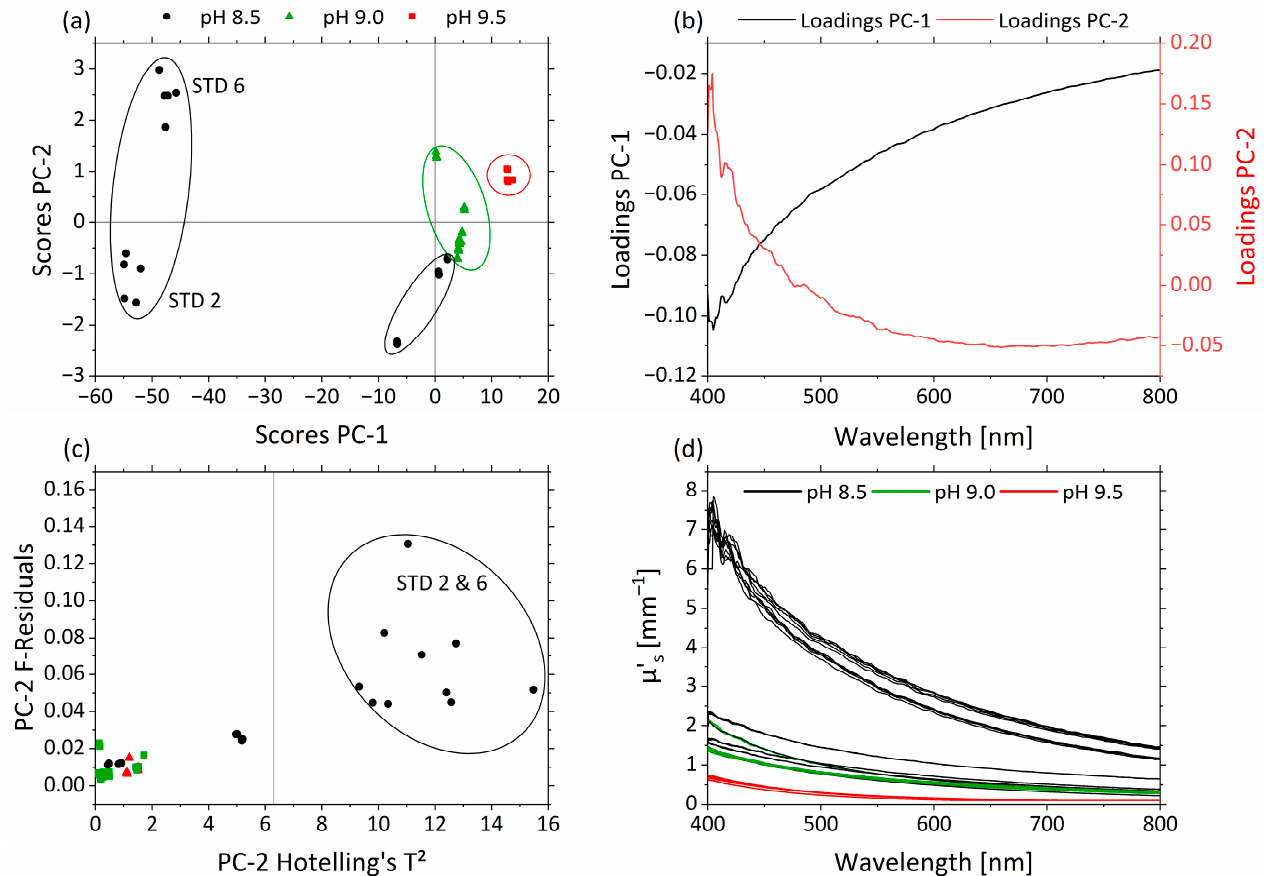
Figure 6. PCA and spectra of µ ’ s . ( a ) Scores plot with pH 8.5 (black circle), pH 9.0 (green triangle) and pH 9.5 (red square) for PC-1 against PC-2. ( b ) Corresponding loadings PC-1 (black) and PC-2 (red). ( c ) Influence plot Hotelling’s T 2 versus F-residuals for PC-2. ( d ) µ ’ s -spectra of pH 8.5 (black), pH 9.0 (green) and pH 9.5 (red).